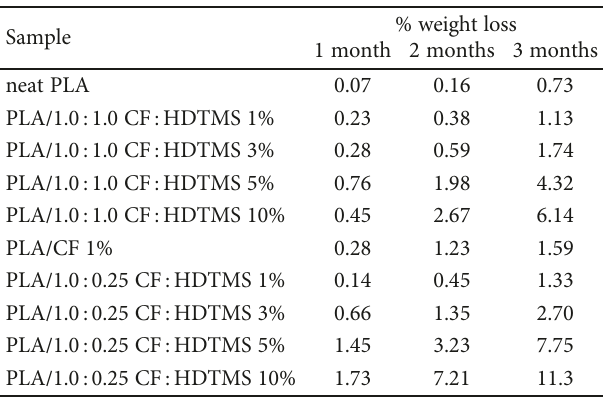
Table 2: Percent weight loss after soil burial